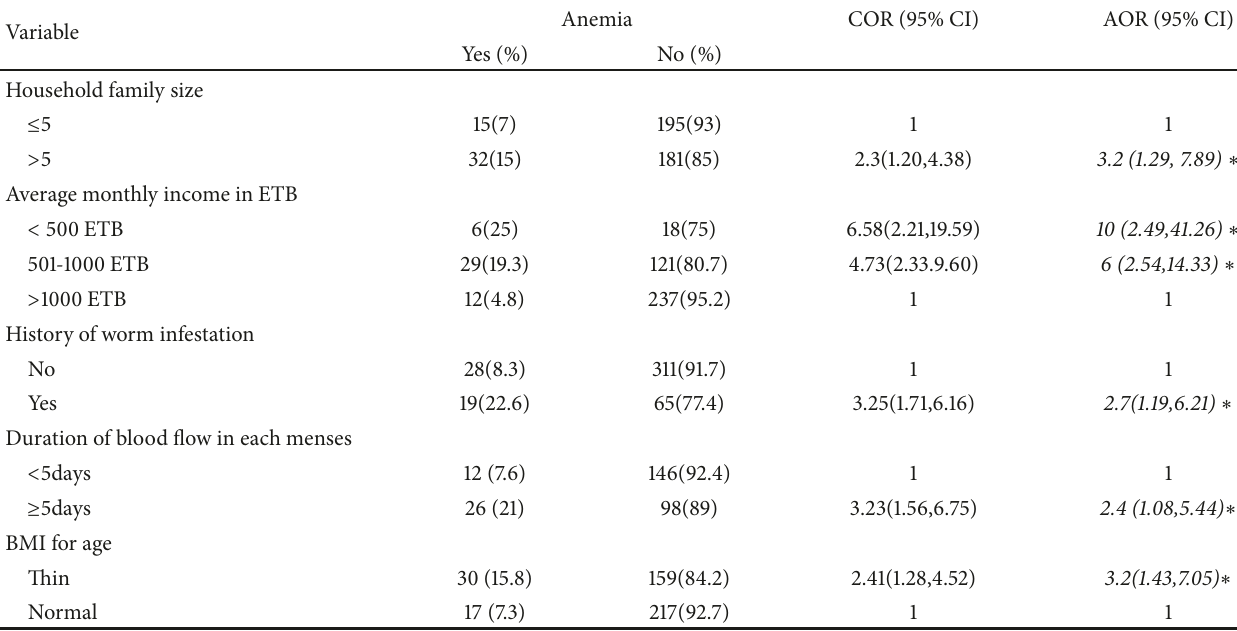
Table 5: Factors associated with anemia among school adolescent girls at rural town of Bahir Dar city administration.